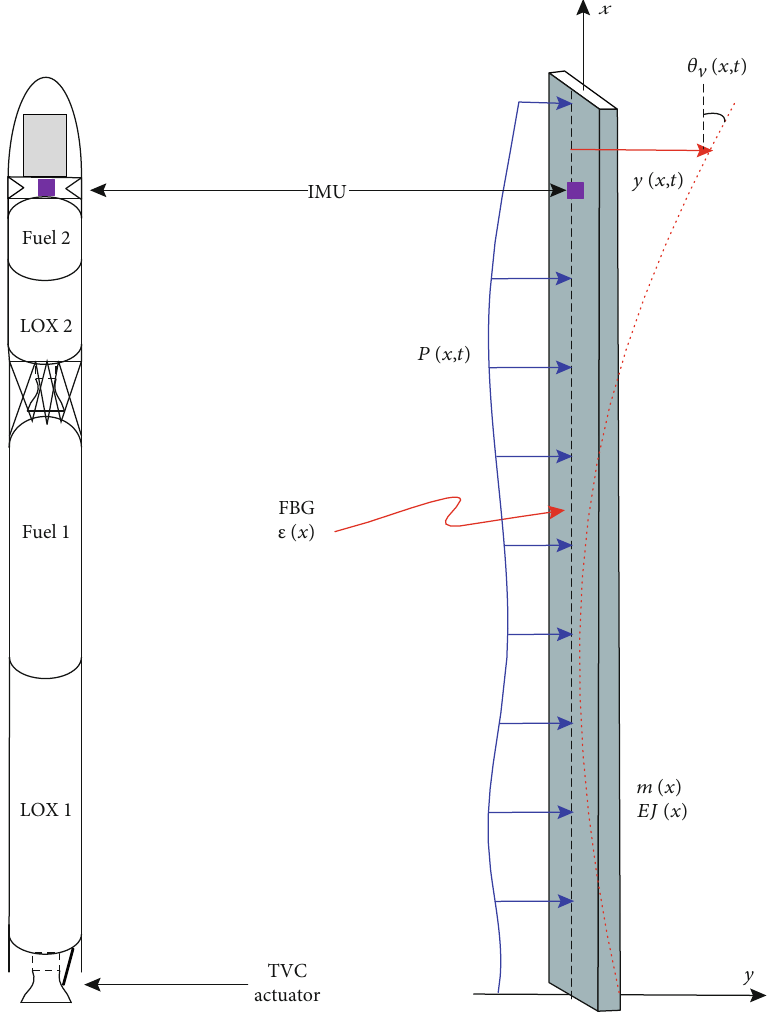
Figure 2: Beam representation of a fl exible